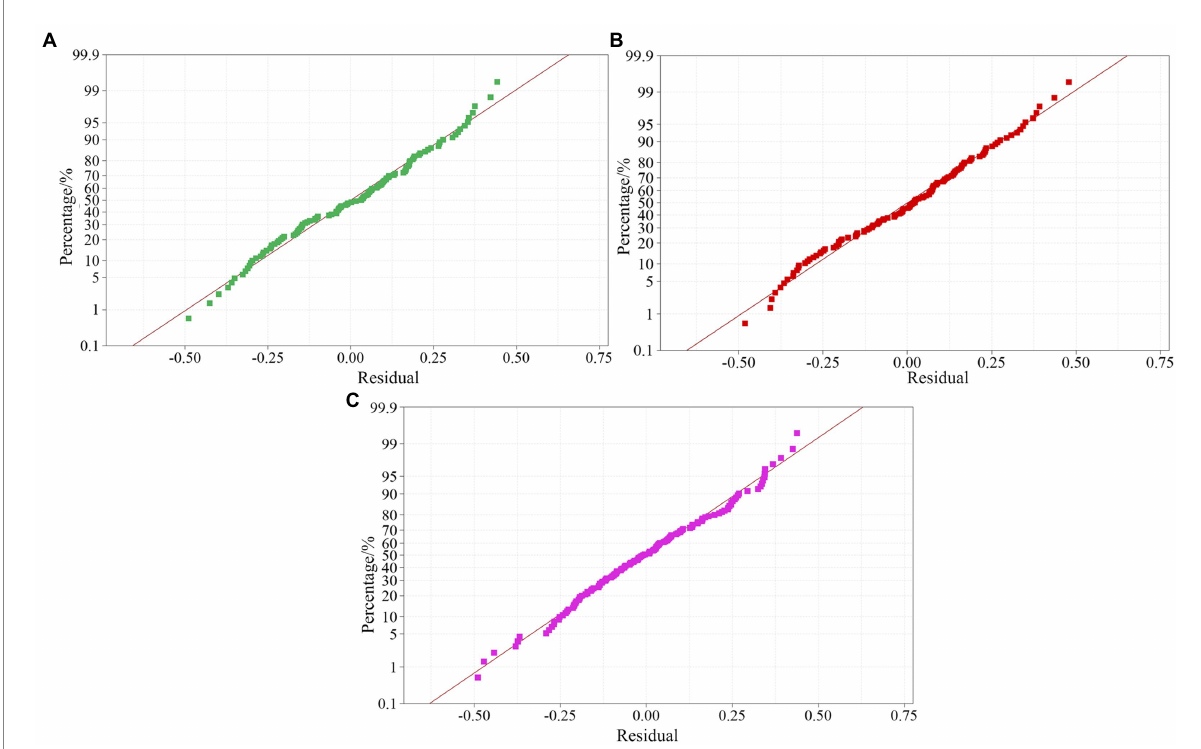
FIGURE 7 Normal distribution of residuals in the canopy leaf area data set at different sprayer fan speeds. (A) 1381 r/min data set. (B) 1502 r/min data set. (C) 1676 r/min data set.